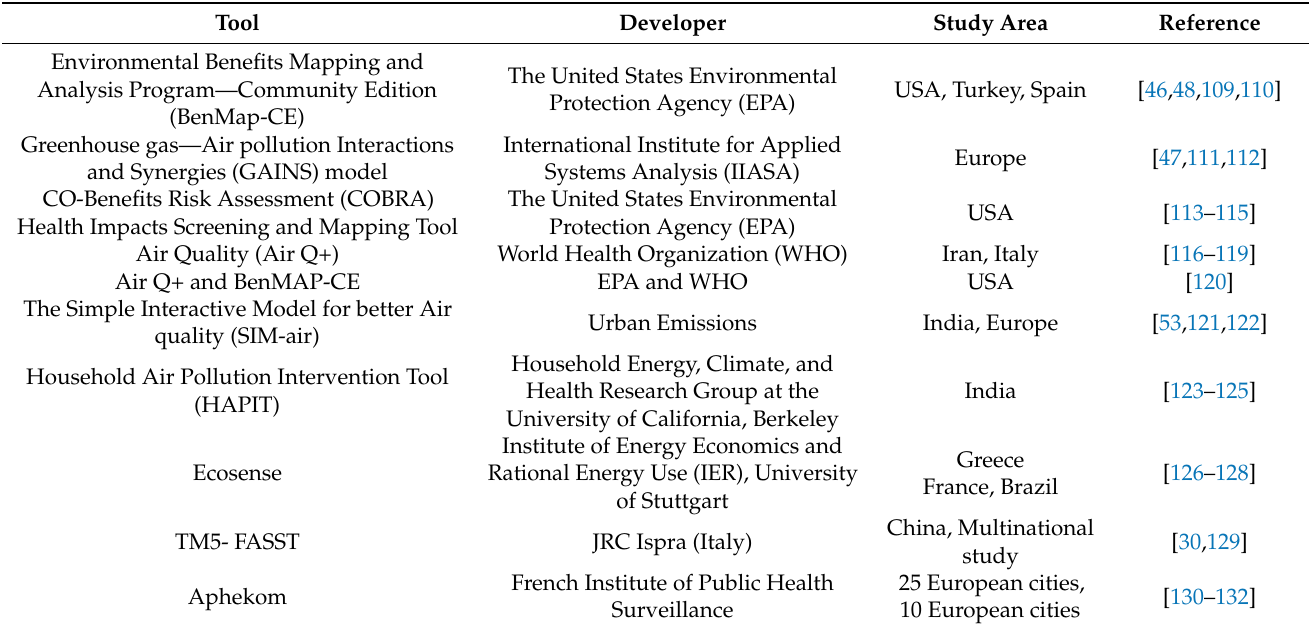
Table 5. Widely used quantitative HRA